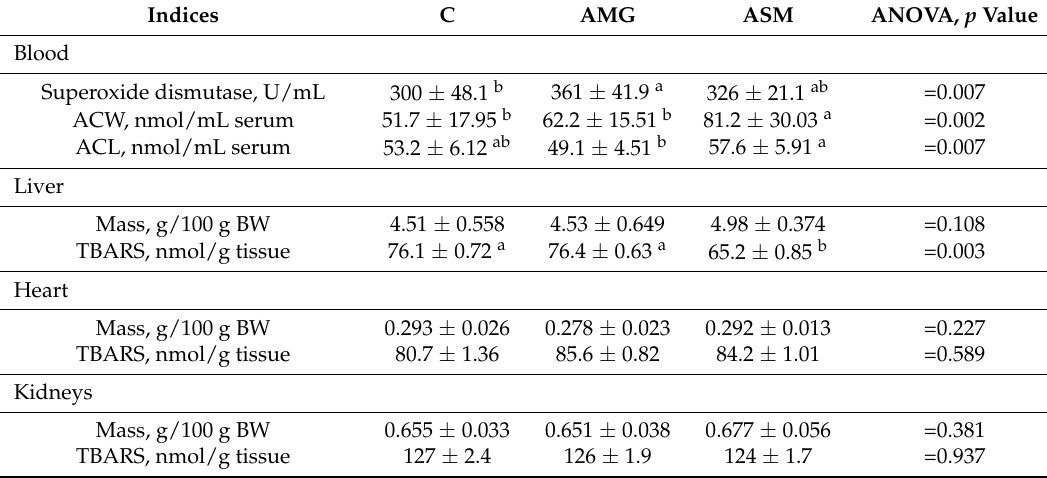
Table 5. Markers of antioxidant status and oxidative stress in